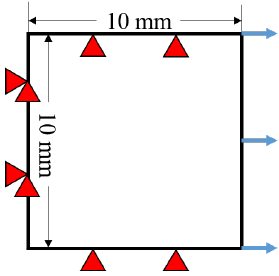
Figure 2. Geometry of the verifying model for